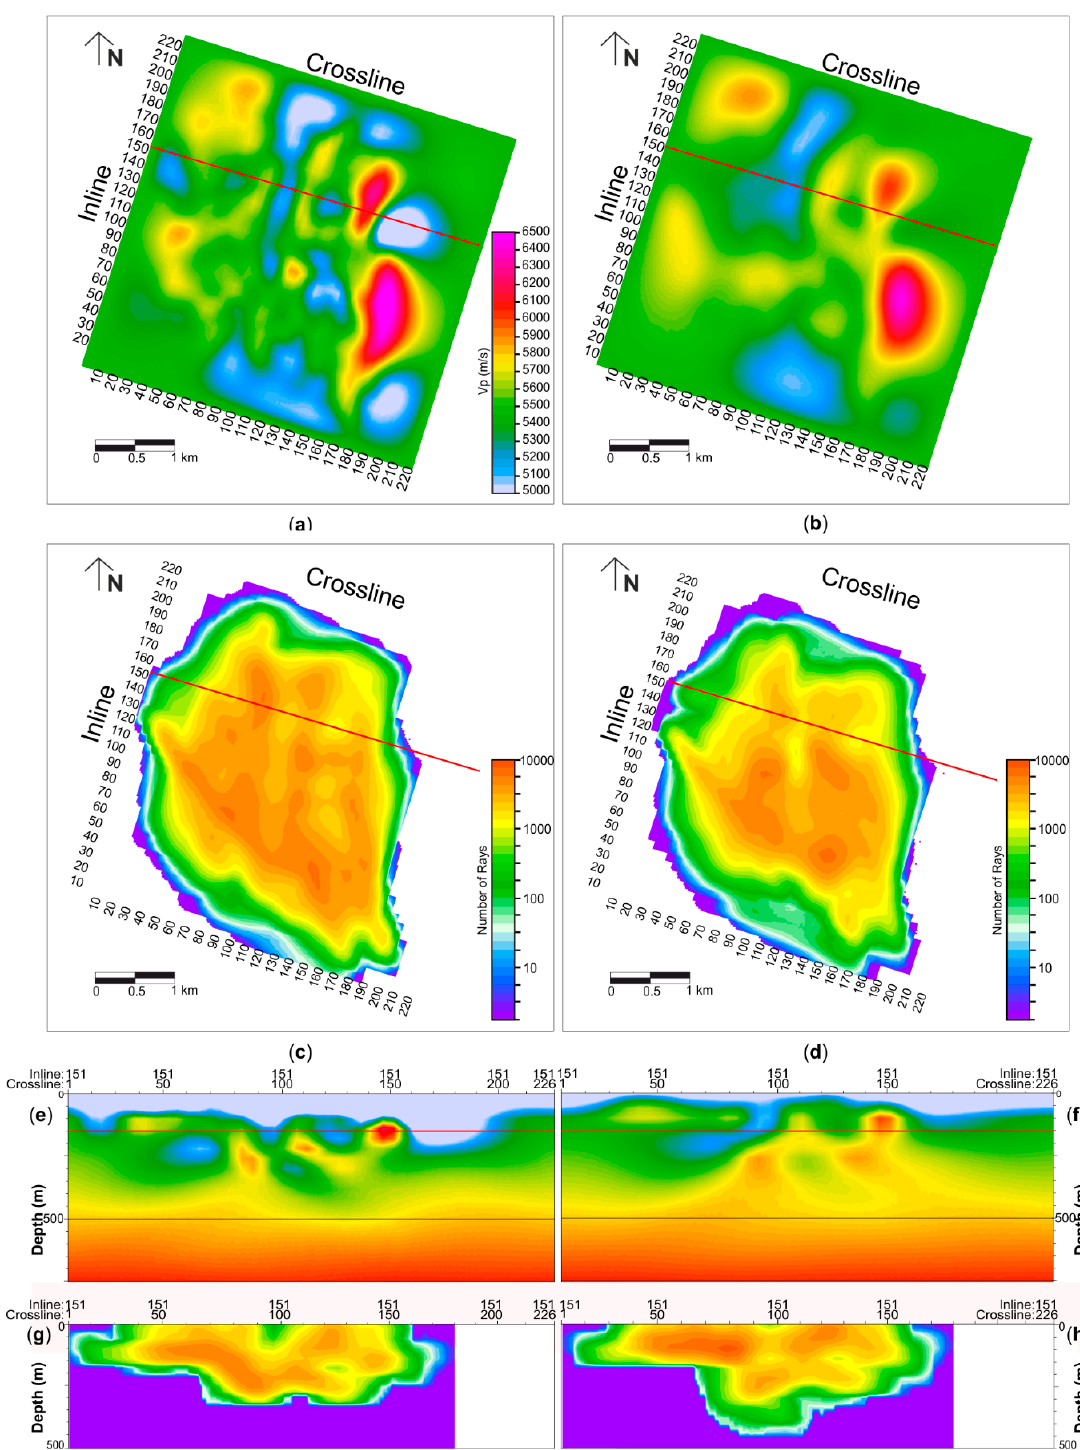
Figure 5. Comparison of first-arrival traveltime tomography (FAT) velocity models and ray-density coverage. Depth slice at 150 m below the datum from: ( a ) P-wave velocity model built from raw picks; ( b ) P-wave velocity model built from picks corrected with refraction statics; ( c ) ray-density coverage map for ( a ); ( d ) ray-density coverage map for ( b ); inline 151 from: ( e ) P-wave velocity model shown in ( a ); ( f ) P-wave velocity model shown in ( b ); ( g ) ray-density for ( e ); ( h ) ray-density for ( f ). It can be observed that the model built from additional statics correction is smoother, has higher ray-density coverage and a greater ray extension in depth with respect to the model built from raw picks.